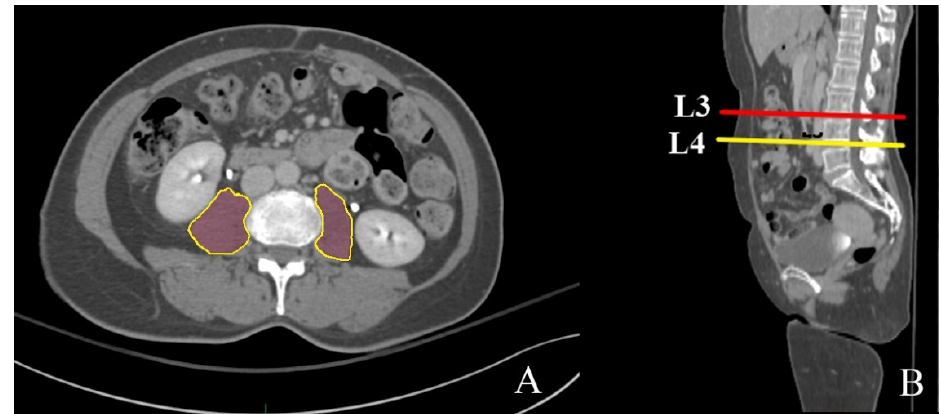
Figure 2. ( A ) Demarcation of the psoas muscle cross-sectional area. ( B ) Measurement level of the psoas muscle at the inferior endplate of the third and fourth lumbar vertebra.